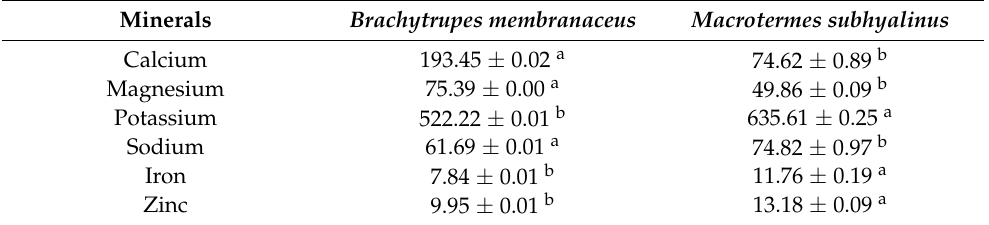
Table 2. Mineral composition (mg/100 g) of Brachytrupes membranaceus and Macrotermes subhyalinus